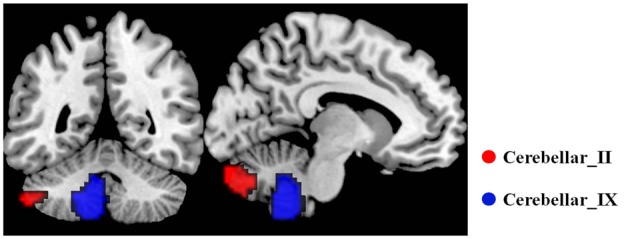
The subregions of cerebellar. In each hemisphere, two subregions were defined including the Crus II and posterior lobule IX using the probabilistic cerebellar atlas with a threshold of 50% minimum probability. Red color represents the Crus II, and green color represents the posterior lobule IX.